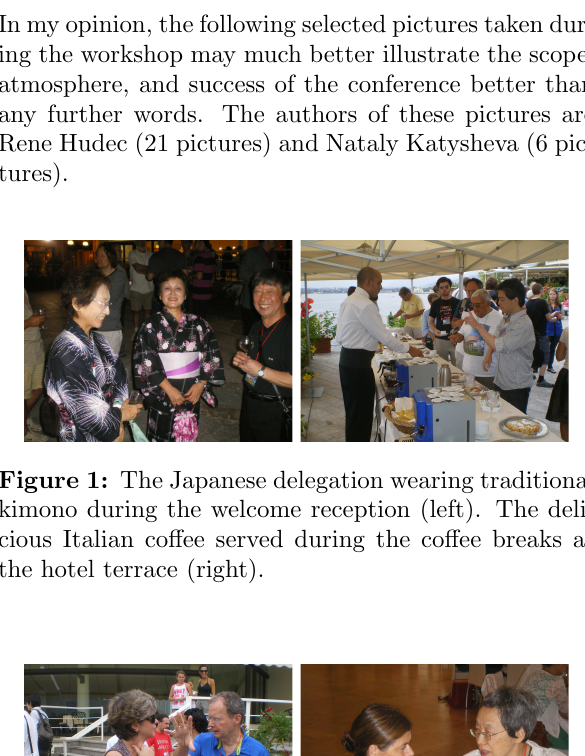
Figure 6: The workshop artistic performance (left) and the beautiful sunset observed from the conference hotel terace (right).